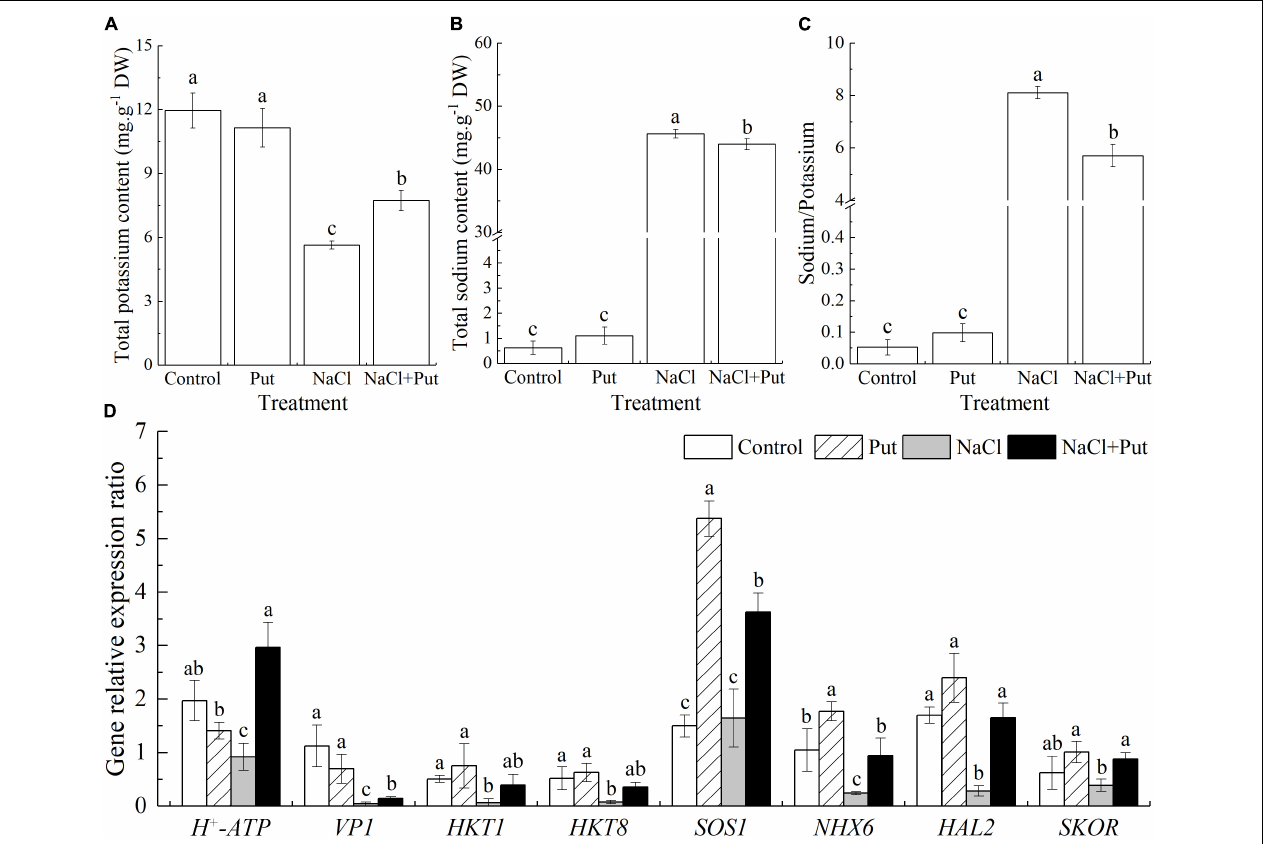
FIGURE 4 | Effects of seed soaking with Put or water on (A) total sodium content, (B) total potassium content, (C) sodium/potassium ratio, and (D) relative expression of genes involved in sodium and potassium transportation ( VP1 , HKT1 , HKT8 , SKOR , HAL2 , H + -ATPase , SOS1 , and NHX6 ) of white clover seedlings after 7 days of germination under normal condition and salt stress. Vertical bars above columns indicate the standard error of each mean ( n = 4). Different letters indicate a significant difference ( P ≤ 0.05). The relative expression of genes is based on the Tr β -action gene